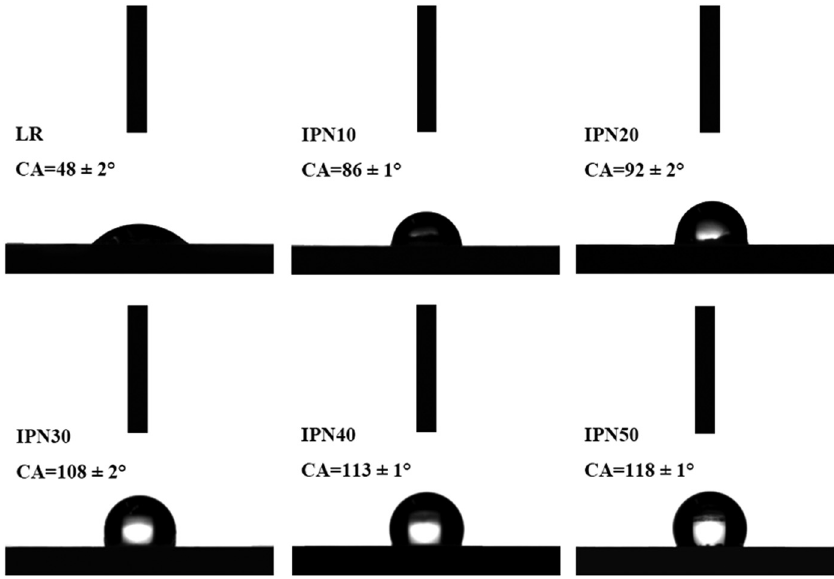
Figure 5: Water contact angle measurement of LR and IPN fi